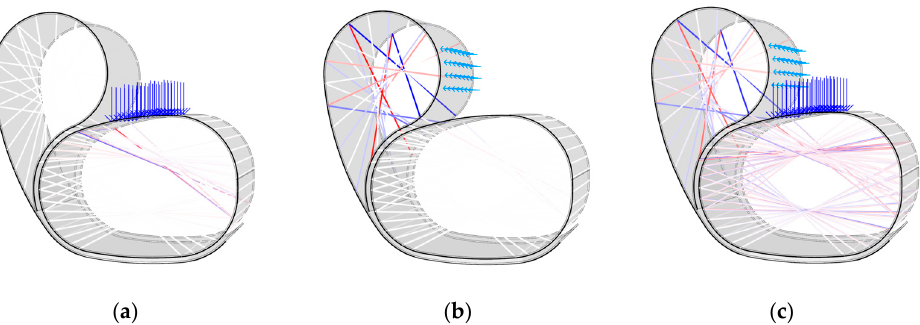
Figure 14. Fibre beam finite element analysis: ( a ) the seat of the chair; ( b ) the back of the chair; ( c ) the